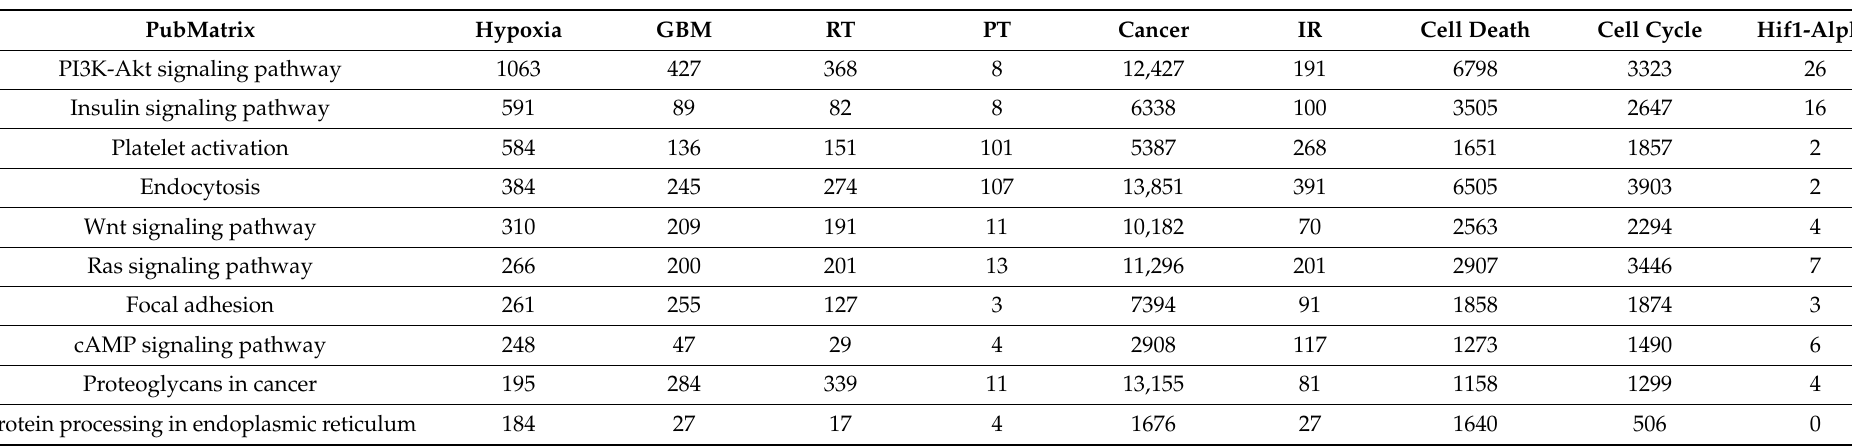
Table 6. Pubmatrix analysis of the top 10 statistically relevant pathways ( p values < 0.05) obtained from the 3740-gene signature upregulated by the combined treatment hypoxia/PT with